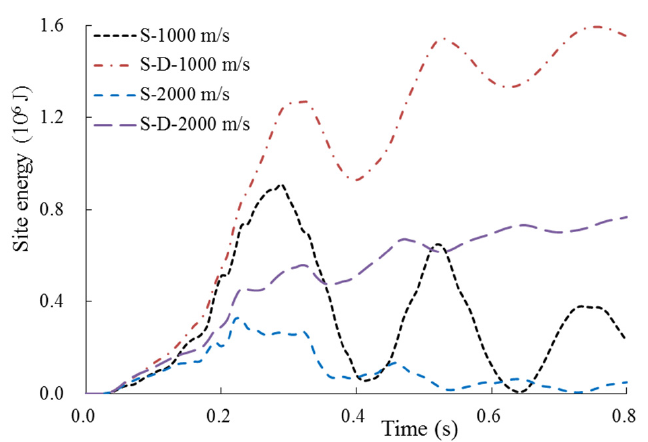
Figure 16. Max plastic strain time-histories of steel plate.